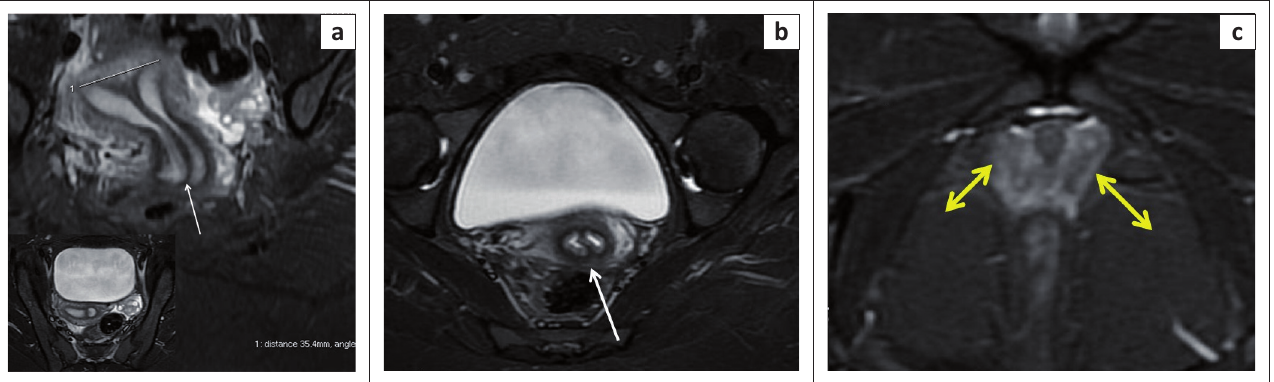
FIGURE 9: Coronal oblique T2 sequence (a) shows no fundal external dipping. There is a partial septum with a muscular and fibrous component separating the endometrial cavity in the fundal region. A single cervix is seen. T2 CUBE maximum intensity projection (MIP) image (b) demonstrates well the inferior sharp end of the septum. Partial septate uterus. Associated left ovarian cyst.